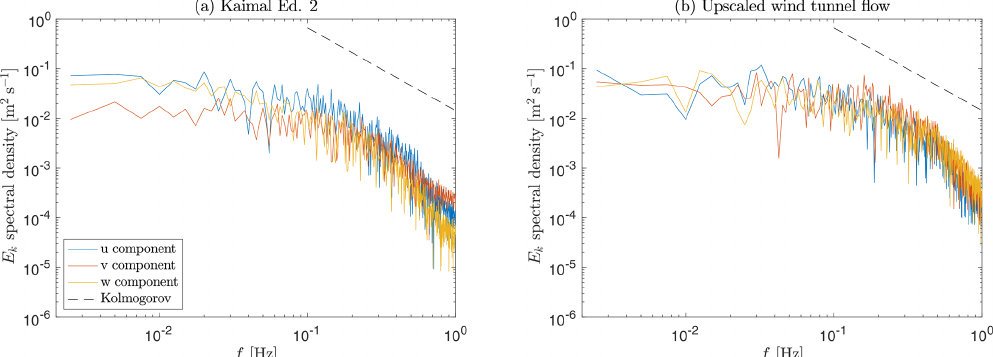
Figure 17. Spectra of turbulent kinetic energy